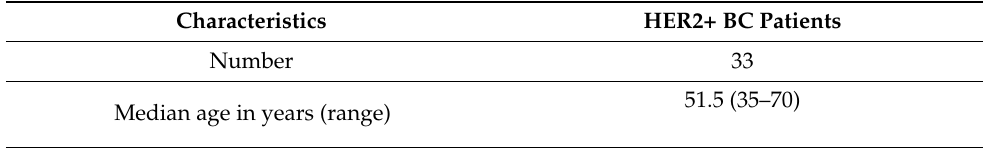
Table 1. Clinicopathological characteristics of HER2+ BC